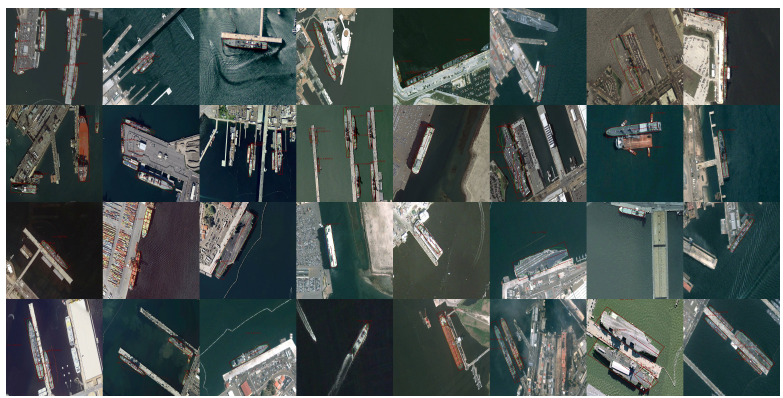
Figure 8. Visualization of detection results from EFN in HRSC2016. The green line in the figure represents the elliptic field calculated by ERF. The red line denotes the circumscribed rectangle of the elliptical field.